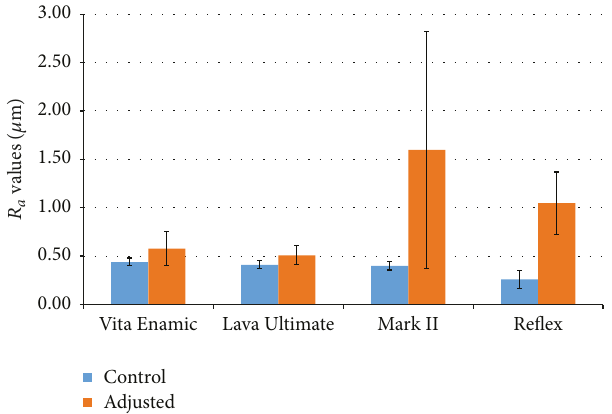
Figure 2: Surface roughness (𝑅 𝑎 ) of control and adjusted surfaces of ceramic materials (average ± SD).